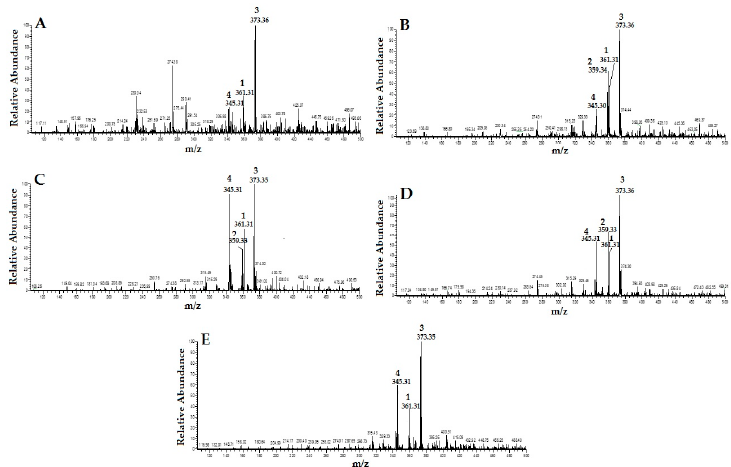
Figure 2. HPLC/MS spectra of different extracts of Orthosiphon stamineus (OS) (1: RA; 2: TMF; 3: SIN;